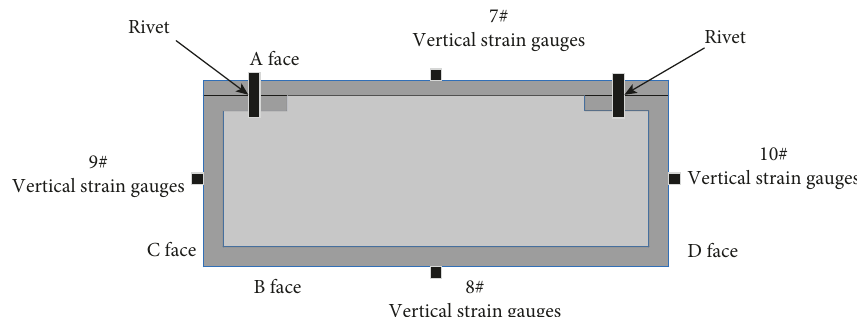
Figure 11: Arrangement of strain gauge on the section.